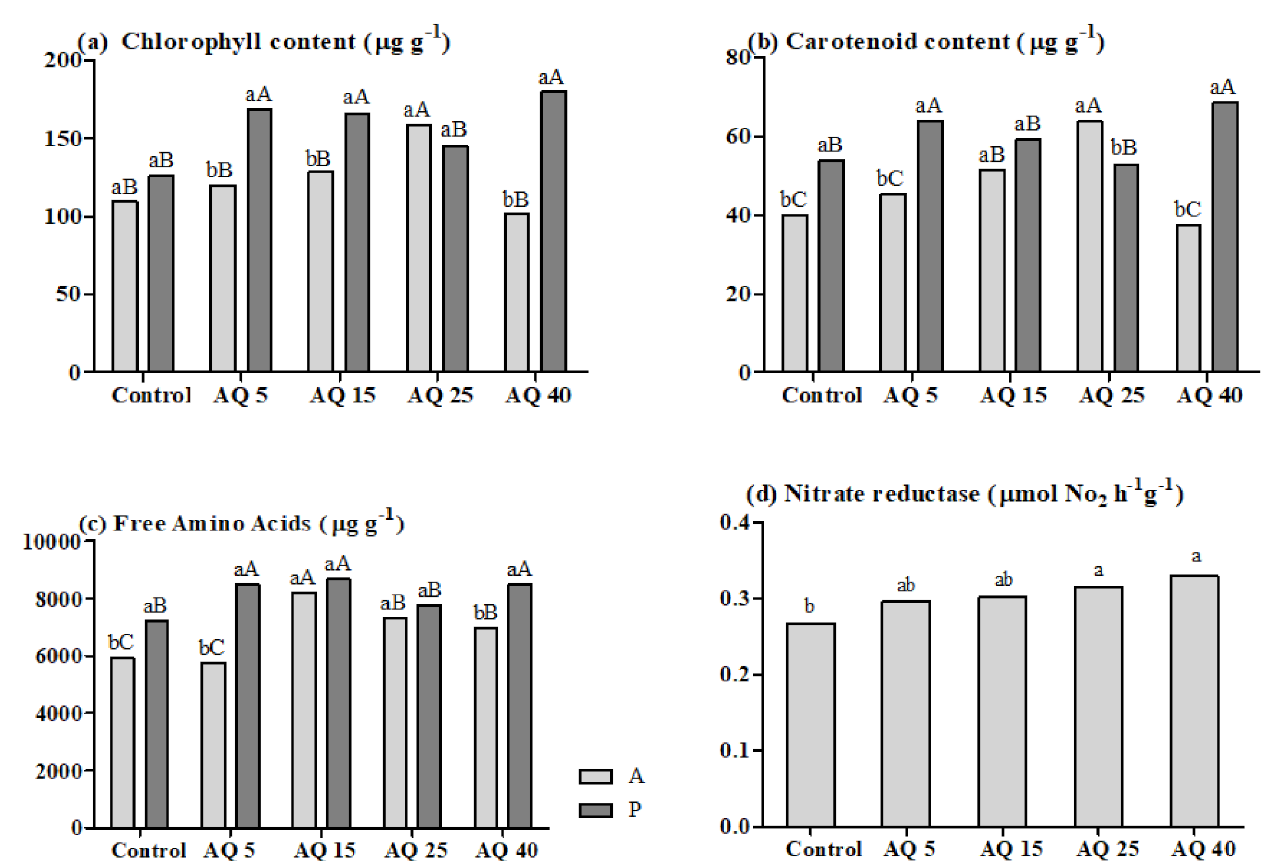
Figure 2. Chlorophyll content ( a ), carotenoid content ( b ), free amino acids, ( c ) nitrate reductase ( d ) in leaves of onion cultivars submitted to foliar applications of biomass suspensions of the microalgae A. quadricellulare at different concentrations. Treatments: 0 g L − 1 (control); 0.05 g L − 1 (AQ 5); 0.15 g L − 1 (AQ 15), 0.25 g L − 1 (AQ 25); 0.4 g L − 1 (AQ 40). Onion cultivars (A = Alvar á ; P = Perfecta). Lower-case letters in the column: cultivars; upper-case letters in the column: treatments. Averages followed by the same letter in the same column do not differ statistically among themselves ( p < 0.05) according to Tukey’s test ( n =